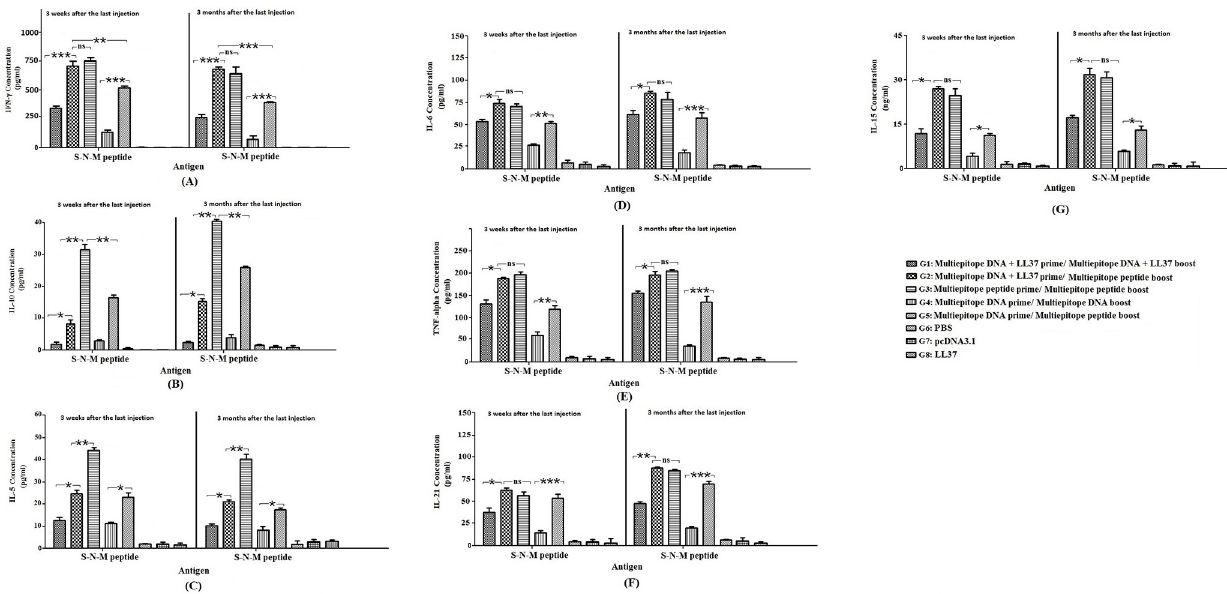
Fig 8. The secretion levels of IFN- γ (A), IL-10 (B), and IL-5 (C), IL-6 (D), TNF- α (E), IL-21 (F), and IL-15 (G) cytokines in splenocytes of mice immunized with S-N-M antigen in various formulations. The levels of cytokines were determined in the supernatant using sandwich-based ELISA as the mean absorbance at 450 nm ± SD from two independent experiments. Significant differences were shown by � p < 0.05, �� p < 0.01, ��� p < 0.001, and non-significant difference was shown by ns ( p >